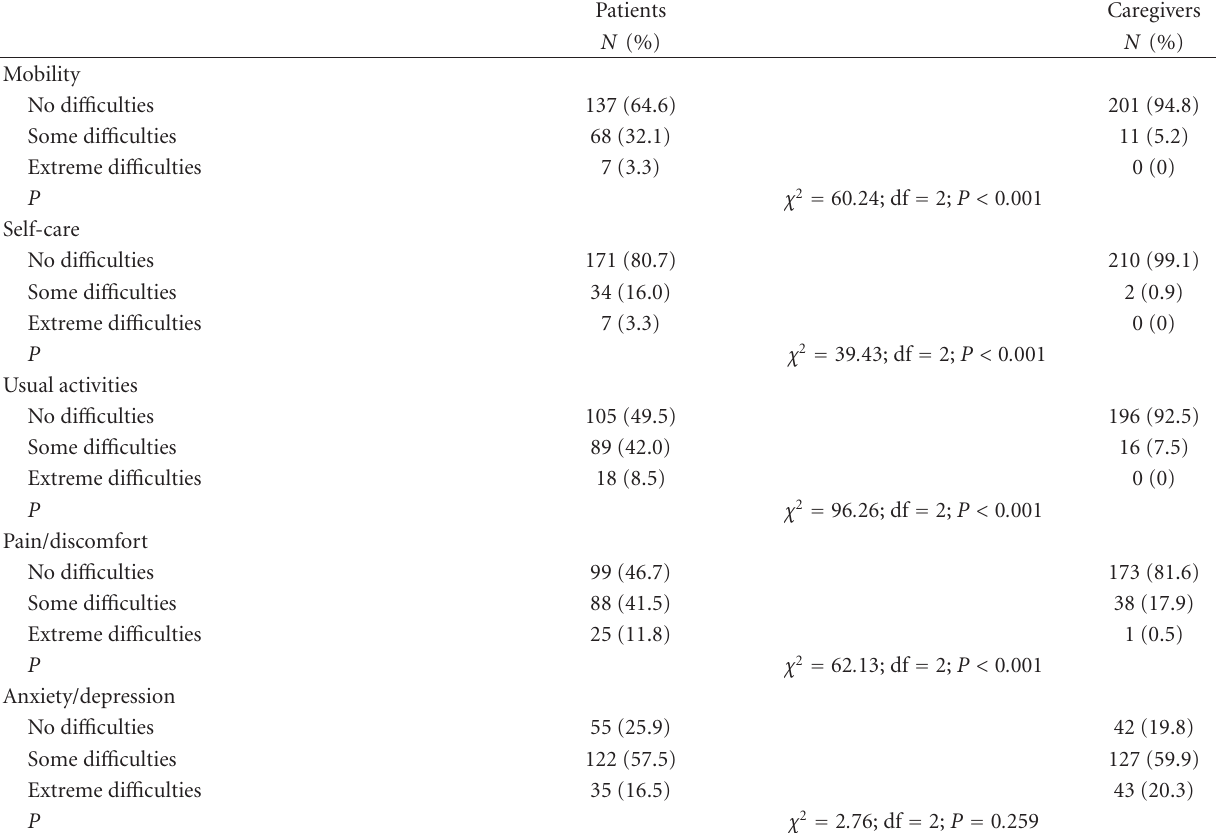
Table 3: Patients’ and caregivers’ EQ-5D dimension